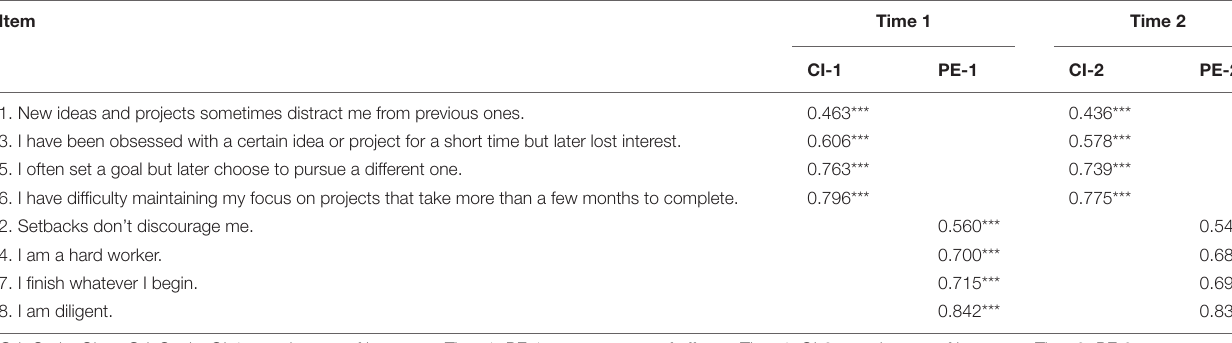
TABLE 4 | Standardized factor loadings for the longitudinal invariance model of the Grit-S.